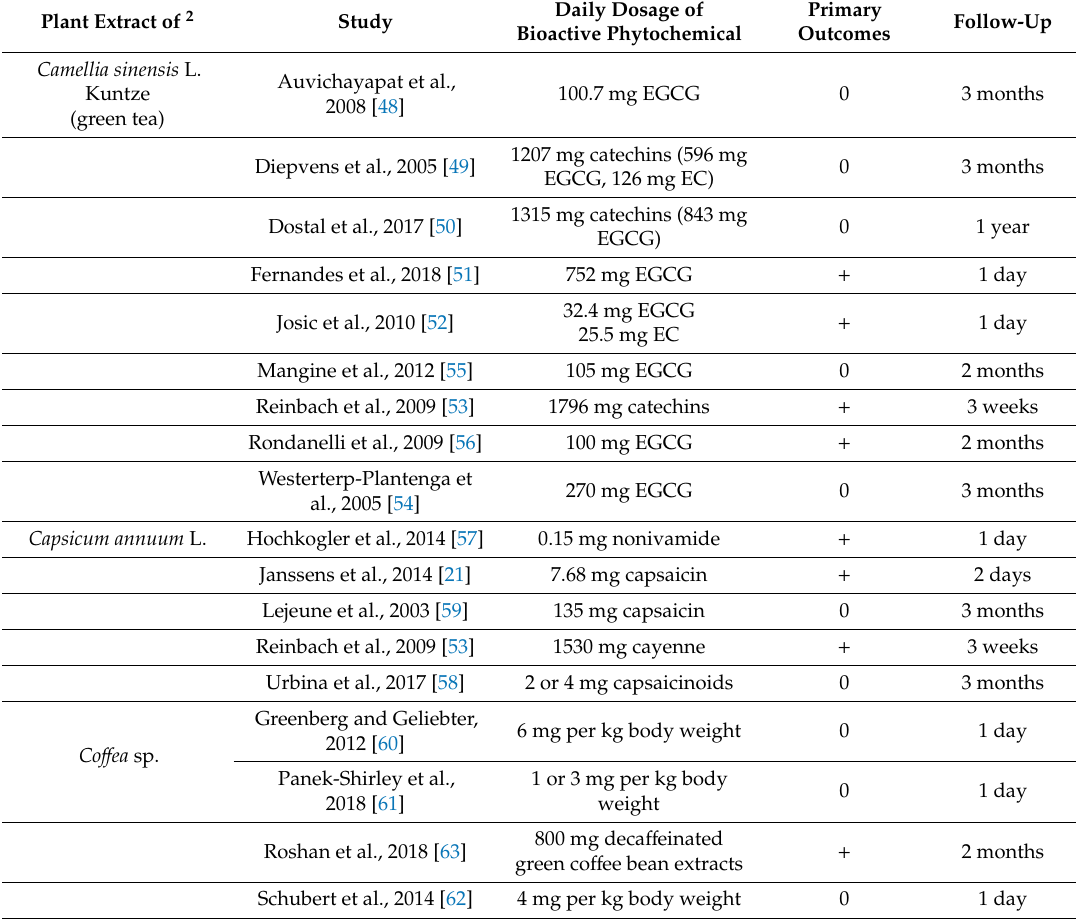
Table 2. Primary outcomes for di ff erent plant extracts.